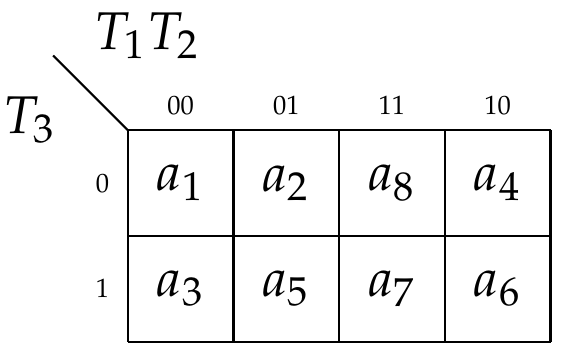
Figure 10. Outcome of encoding of states and state classes.